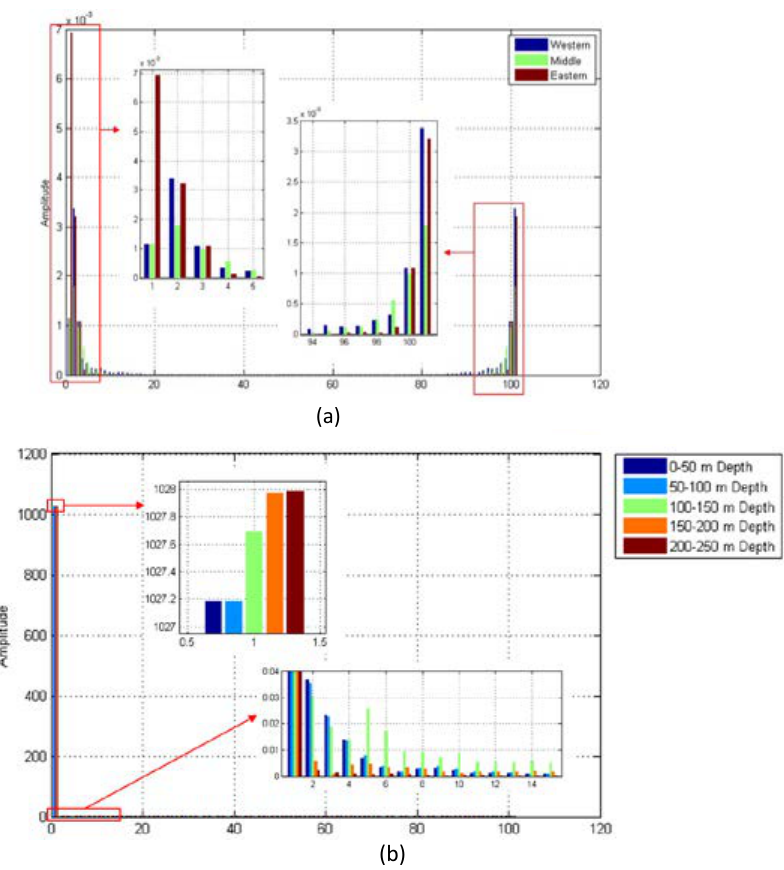
Fig. 6: The FFT value at the equator on the 37th day of (a) the sea level, (b) the density